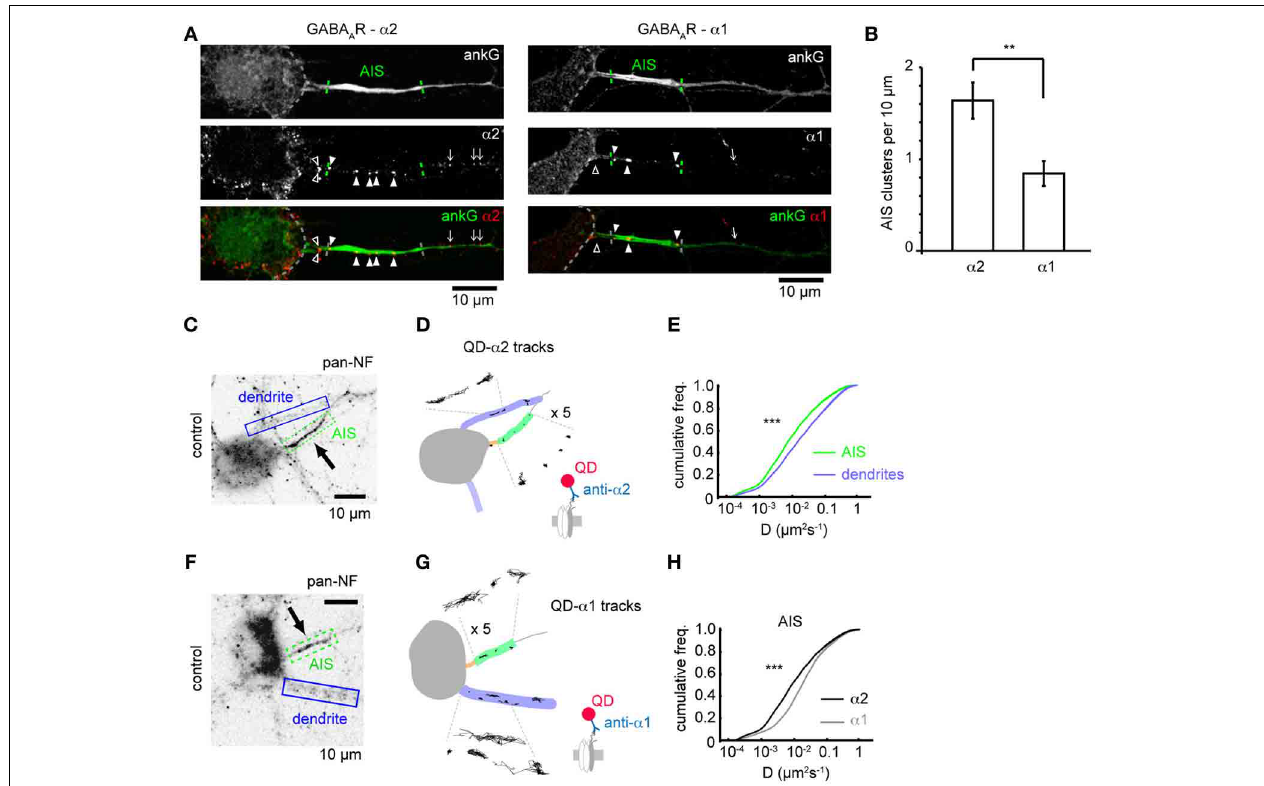
FIGURE 1 | GABA A R clustering and lateral mobility at the axon initial segment. (A) Example neurons stained for ankG and the GABA A R α 2 (left) and α 1 subunits (right). Outline of soma, AIS position and gephyrin cluster positions along the axon are indicated (open arrowhead, cluster before AIS; closed arrowhead, cluster within AIS; arrow, cluster beyond AIS). (B) Clusters (normalized per 10 μ M of AIS length) of the α 2 subunit are more numerous in the AIS than the clusters of the α 1 subunit, ( p = 0 . 01, n = 5 experiments). (C) Neurofascin (pan-NF) staining delineates the AIS (green). Dendrites (blue) are